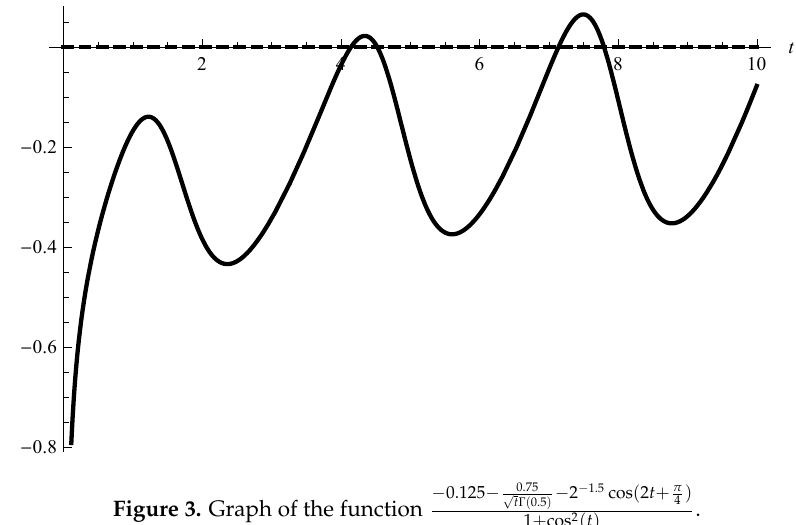
Figure 3. Graph of the function